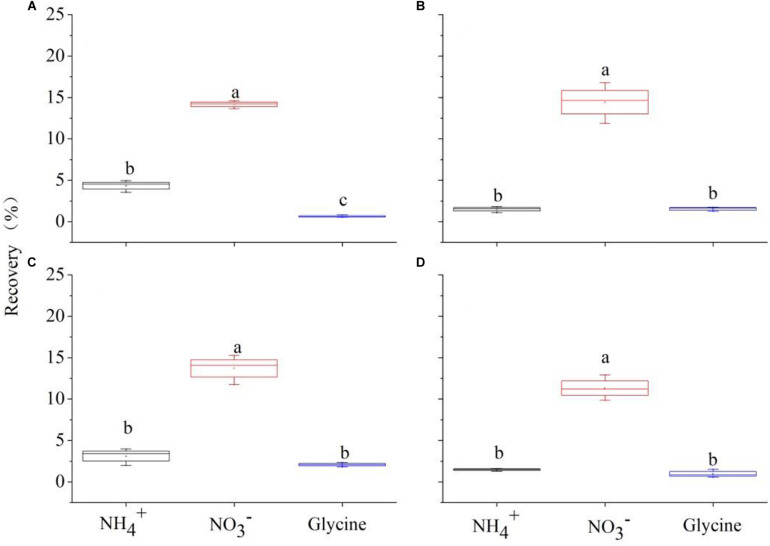
15N recovered by Carex thunbergii (% of added 15N) from NH4+, NO3-, and glycine-N 2 h after 15N injection under competition regime of 4:0 (Carex thunbergii: Polygonum criopolitanum, A), 3:1 (B), 2:2 (C), and 1:3 (D), respectively. The bars and error bars show means ± SE (n = 3).